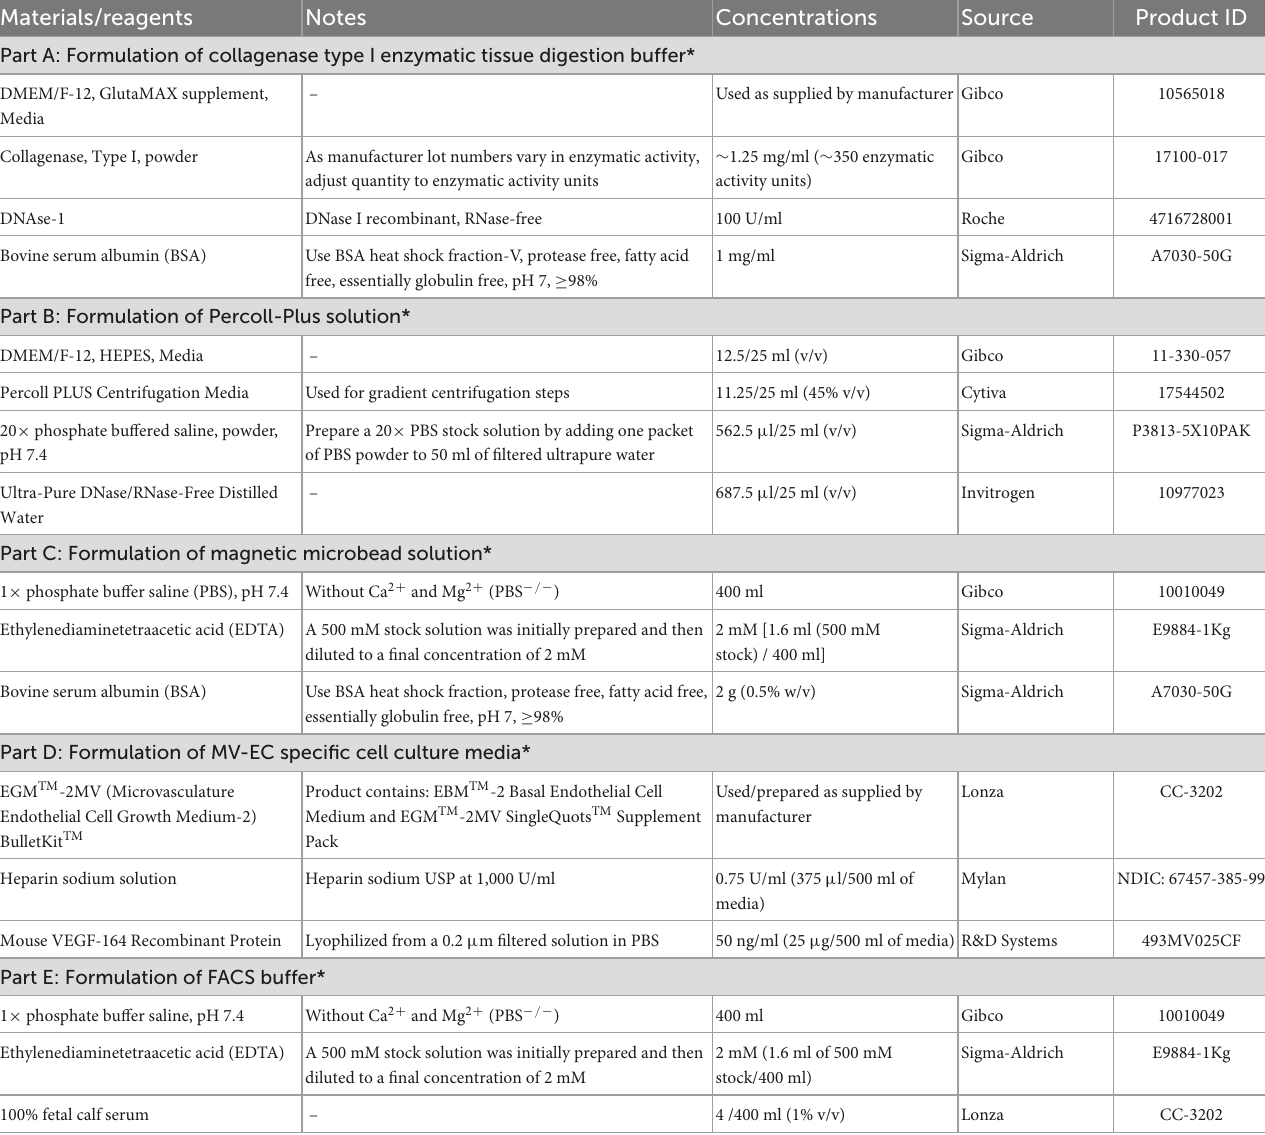
TABLE 1 Compositions and components of buffers and solutions for primary MRPEC